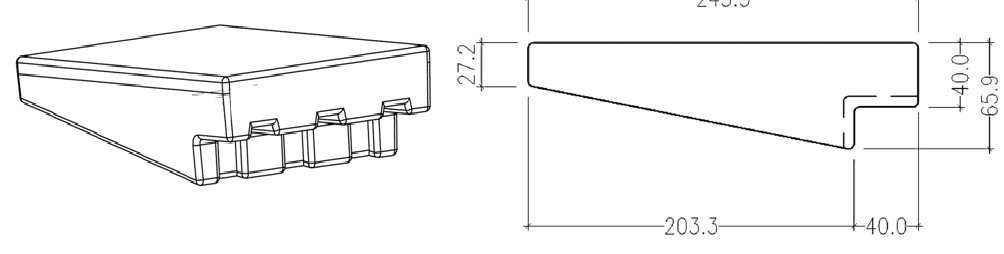
Figure 9. The grain size of the drainage layer. Conceptually, the presence or absence of saturation of the drainage layer is of special importance in the operation of WSBs. For this reason, additional tests were performed to determine the origin of the drainage flow. The first four rows of WSBs were sealed with the aim of reducing leaks and simulating the first section of a real spillway chute with WSBs and an overlapping slab in the upper area (Figure 1b). The drainage flow was firstly measured with the free drainage condition, d 1, and then the blocks were placed over a granular drainage layer, d 2, in order to determine the pattern of the seepage through the blocks towards the drainage layer along the chute with both drainage conditions. Next, the origin of the leakage was investigated with the aim of discriminating between the leaks through the contact joints, which were longitudinal joints and transverse joints in the area of block overlap, as well as through the vents (Figure 10). These types of tests